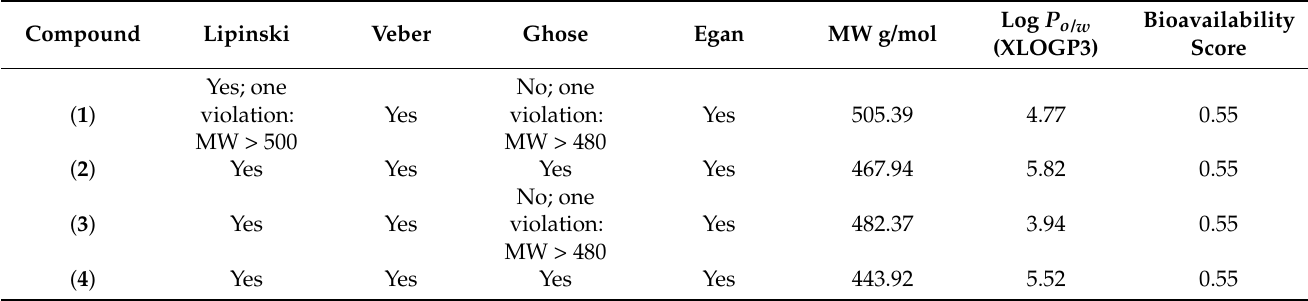
Table 4. The drug-likeness features according to Lipinski, Veber, Ghose, and Egan rules.